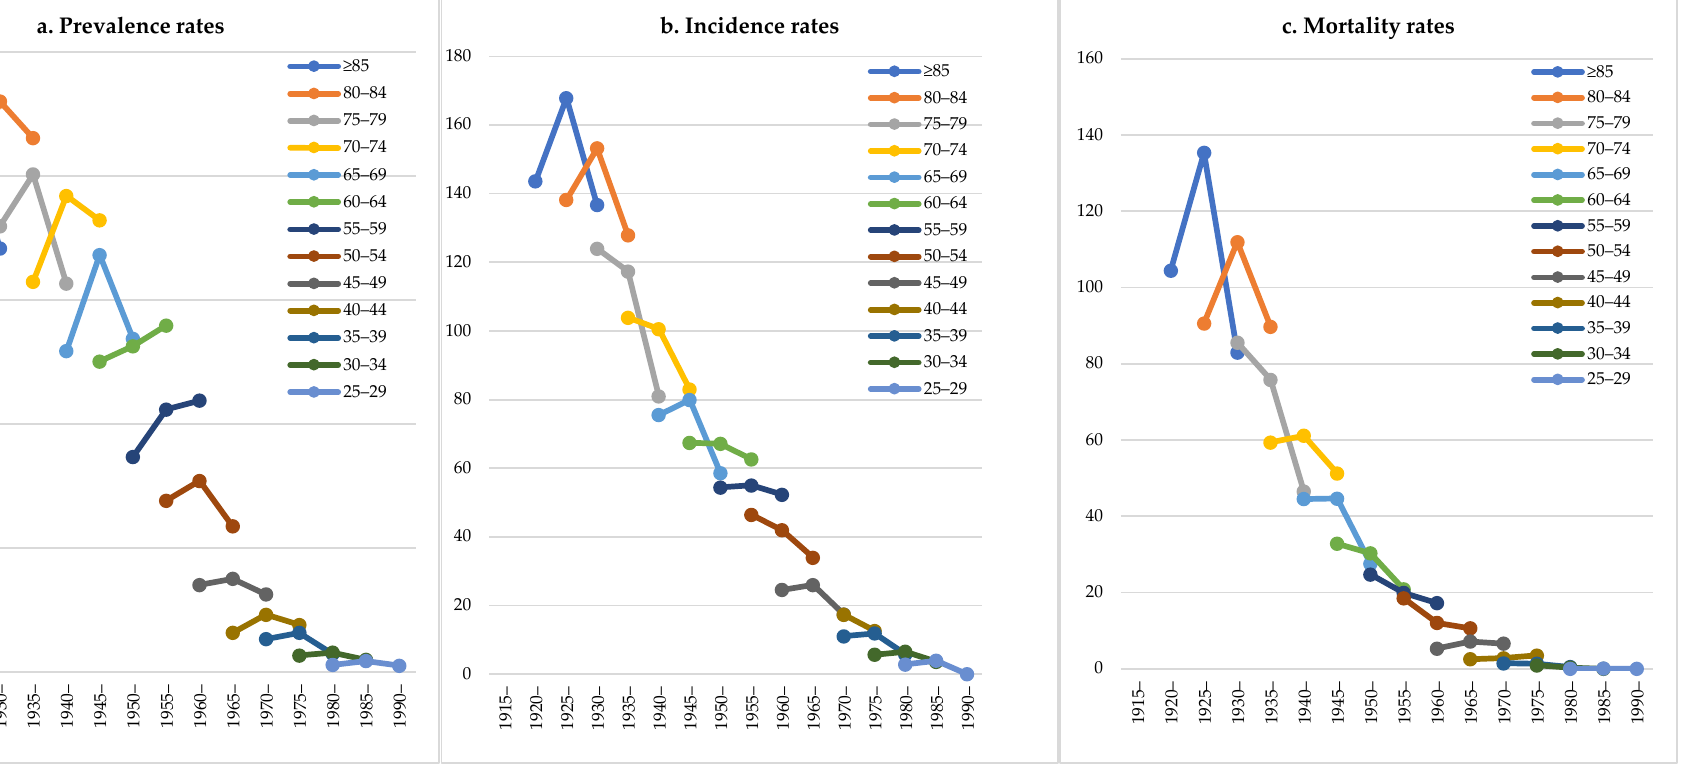
Figure 4. Cohort-specific prevalence, incidence, and mortality rates of HCC by age group.